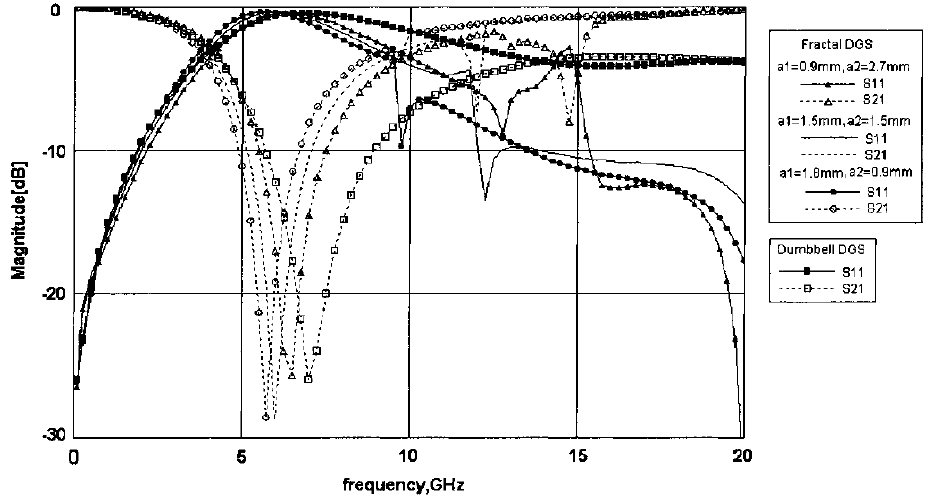
FIGURE 2 Electromagnetic simulation for the fractal and dumbbell DGS.